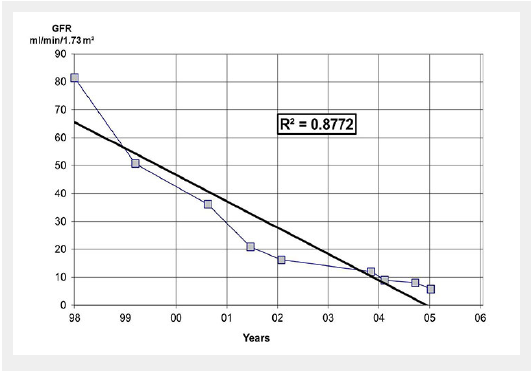
An example from a patient of a graph with the estimated GFR plotted against time. The intersection of the line with a GFR of 10 ml/min/ 1.73m2 roughly denotes the time needed for renal replacement